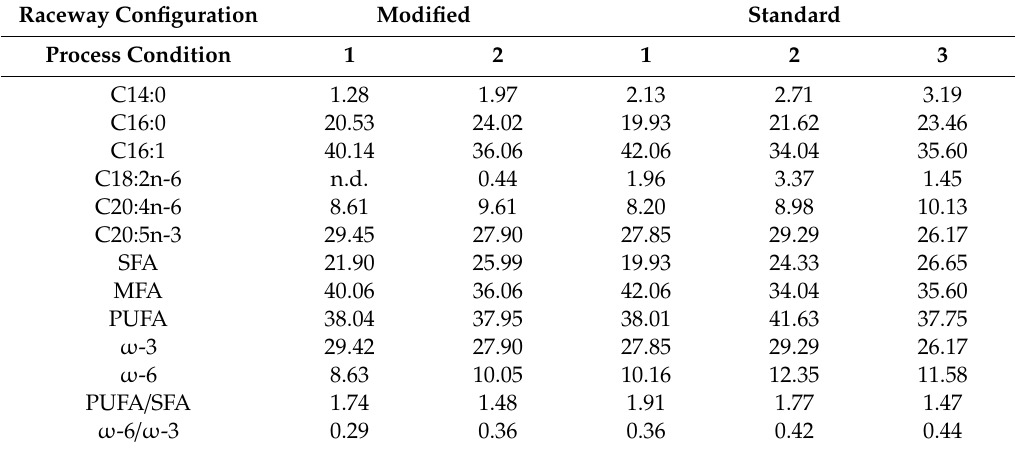
Table 6. Fatty acid profile of the biomass produced (n.d., not detected). Values represent an average of two biological replicates.